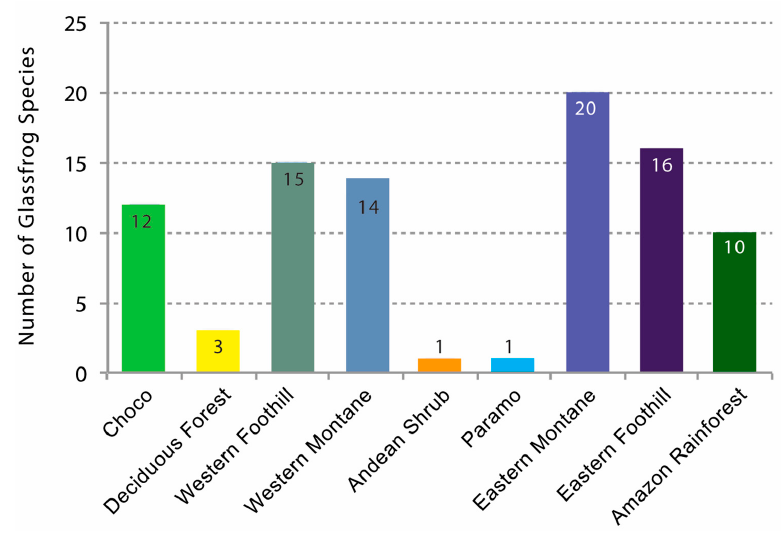
Figure 232. Species richness of glassfrogs per biogeographic region in Ecuador.